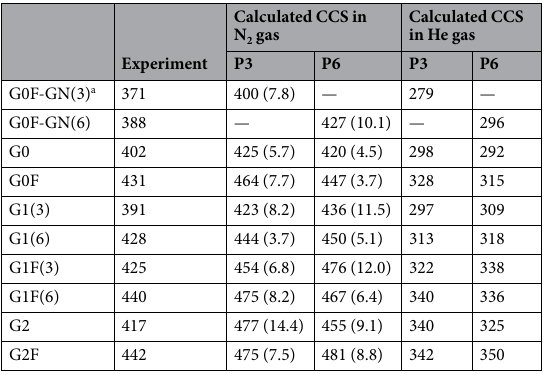
Table 2. Calculated collision cross sections (in Å 2 ) in N 2 and He drift gas for each of two protonation states, P3 and P6, of ten PA-glycans. The experimental values in the presence of N 2 drift gas are also listed. The percentage difference between the experimental and calculated CCS in N 2 drift gas (%diff = CCS calc − CCS exp / CCS exp × 100%) are given in parenthesis. a The core GlcNAc, rather than that of the α 1-3 branch, was